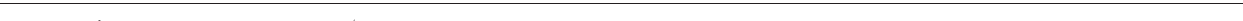
FIGURE 8 | gut phenotype; n = 4 for Plc γ 2 − / − mice with severe gut phenotype). Bars, 500 µ m. (C,D) Images are shown of LYVE-1 and PDPN expression next to the transverse sinus and superior sagittal sinus of Plc γ 2 + / + ( n = 8), Plc γ 2 − / − mice with mild ( n = 3) (C) and severe ( n = 6) (D) gut phenotype. Bars, 1,000 µ m. (E) Quantitative data are shown for clinical scores (0–15) representing structural malformations of the meningeal lymphatics in Plc γ 2 + / + and Plc γ 2 − / − mice with severe or mild phenotype in the gut (Mean ± SEM; One-way ANOVA; Dunnett’s post-hoc test; n = 15 for Plc γ 2 + / + mice; n = 5 for Plc γ 2 − / − mice showing mild gut phenotype, n = 11 for Plc γ 2 − / − mice displaying severe gut phenotype; ** P < 0.01 vs. Plc γ 2 + / + ). (F–H) Quantitative data are shown for differences in the total length of the meningeal lymphatics (F) , total length of the meningeal lymphatics adjacent to the superior sagittal sinus (G) , and adjacent to the transverse sinuses (H) in Plc γ 2 + / + and Plc γ 2 − / − mice displaying severe or mild phenotype in the gut (Mean ± SEM; One-way ANOVA; Dunnett’s post-hoc test; n = 15 for Plc γ 2 + / + mice; n = 5 for Plc γ 2 − / − mice showing mild gut phenotype, n = 11 for Plc γ 2 − / − mice displaying severe gut phenotype; * P < 0.05 vs. Plc γ 2 + / + ; ** P < 0.01 vs. Plc γ 2 + / + ; *** P < 0.001 vs. Plc γ 2 + / + ). (I) Confocal images are shown of LYVE-1 and F4/80 immunostaining of whole-mount meninges of young adult Plc γ 2 + / + and Plc γ 2 − / − mice